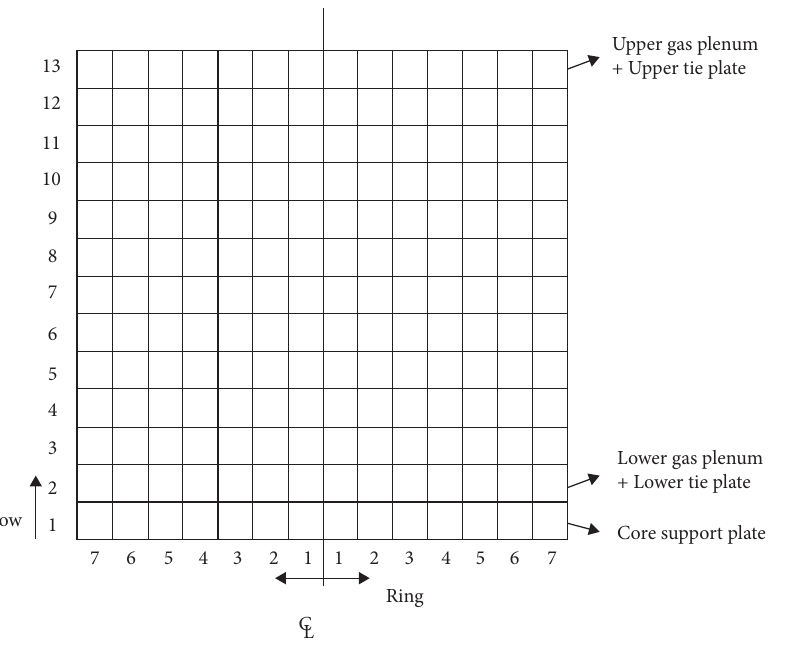
Figure 2: Core nodalization.